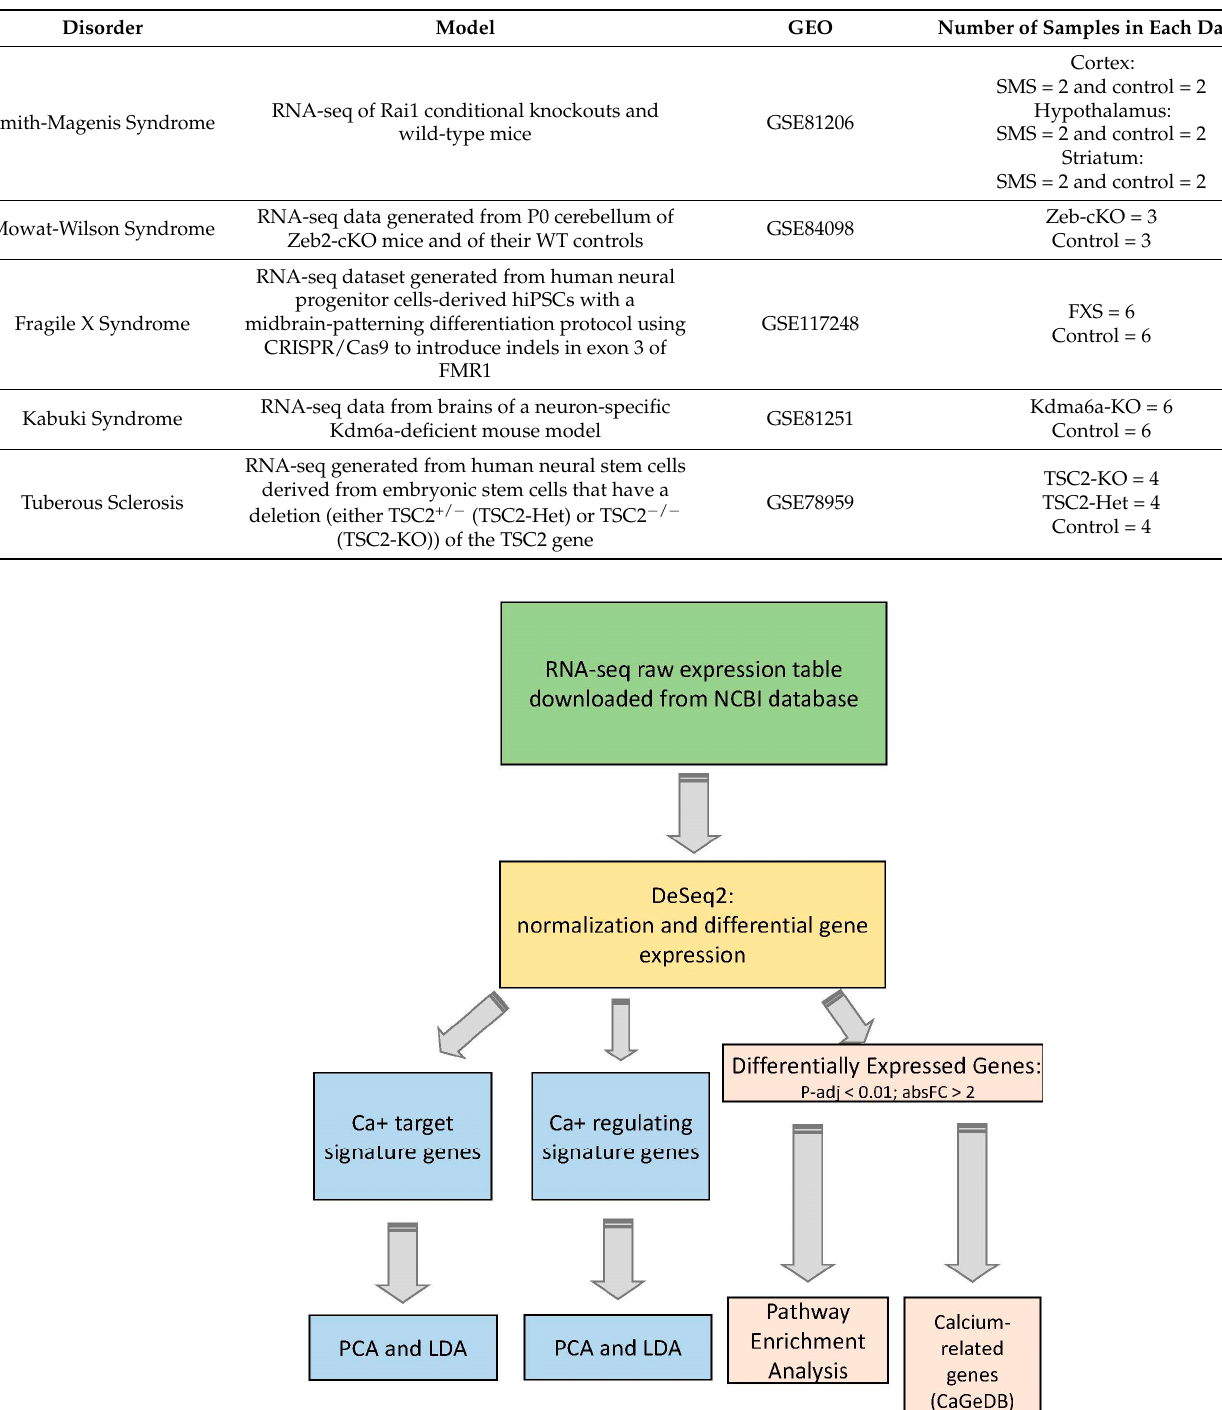
Table 1. Data sets downloaded from NCBI for analyses.